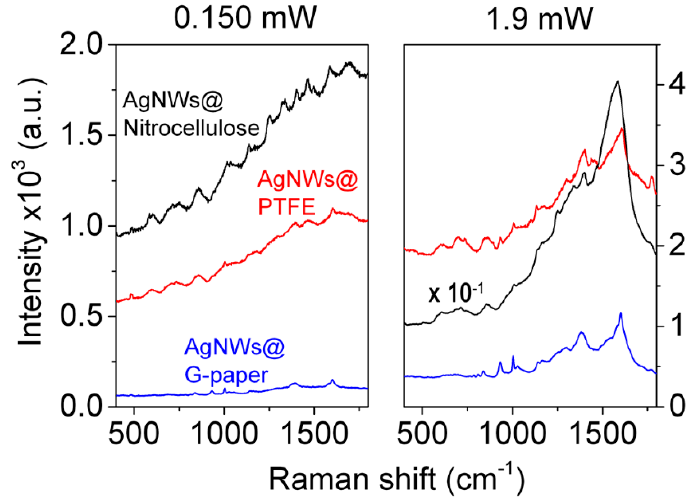
Figure 6. Background SERS profiles of AgNWs sprayed on nitrocellulose, PTFE and G-paper at ( left ) 0.150 mW and ( right ) 1.9 mW laser power at 532 nm. Spectra represent the average of over 20 acquisitions.